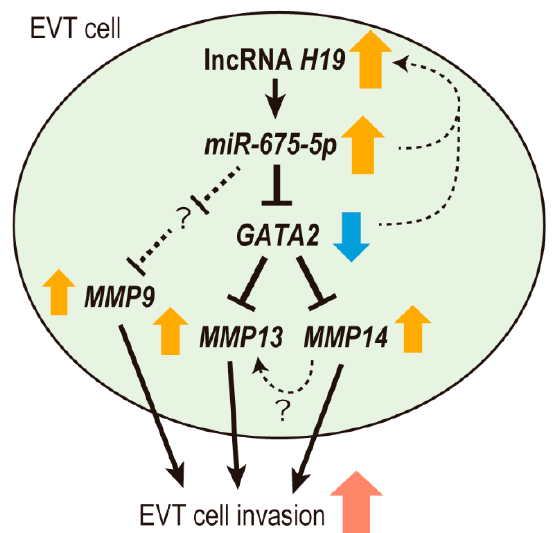
Figure 5. Proposed model for miR-675-5p / GATA2 -mediated EVT cell invasion. miR-675-5p -mediated GATA2 inhibition upregulates MMP14 and MMP13 , resulting in the promotion of EVT cell invasion. miR-675-5p also upregulates MMP9 in EVT cells by other target genes of miR-675-5p . Moreover, miR-675-5p / GATA2 promotes H19 expression, suggesting the existence of a H19 - miR-675-5p / GATA2 positive feedback system.